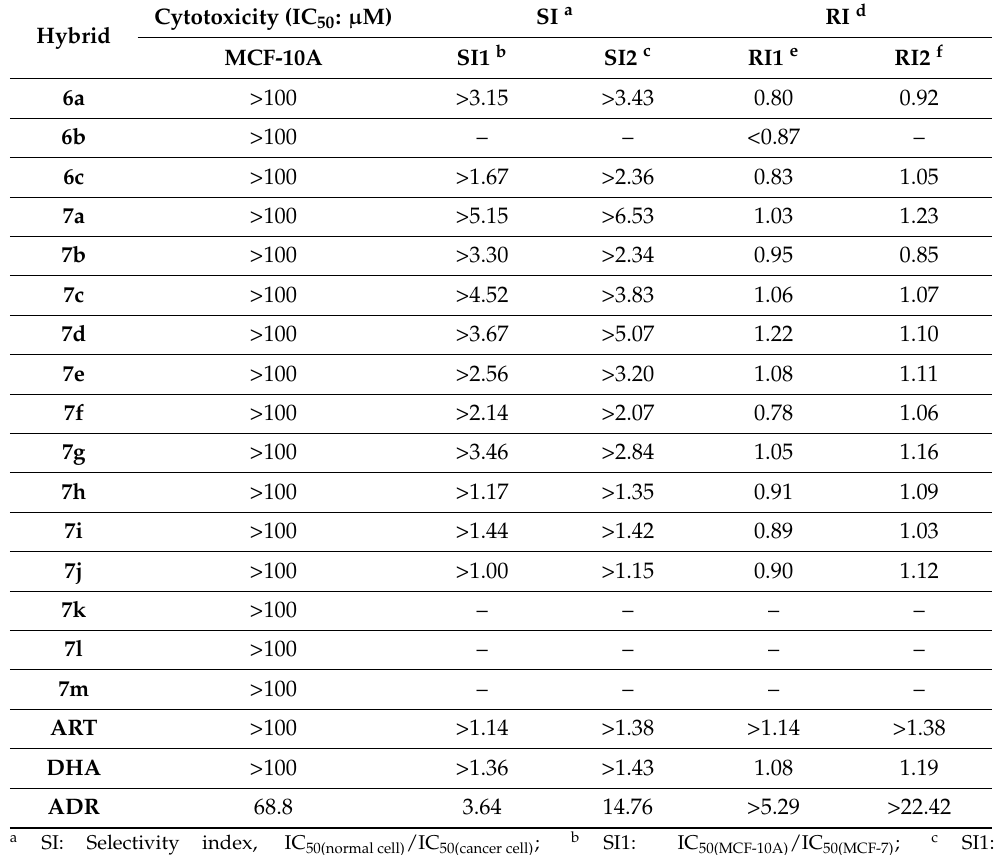
Table 2. The cytotoxicity, selectivity index and resistance index values of DHA-5-methylisatin hybrids 6a–c and 7a–m .